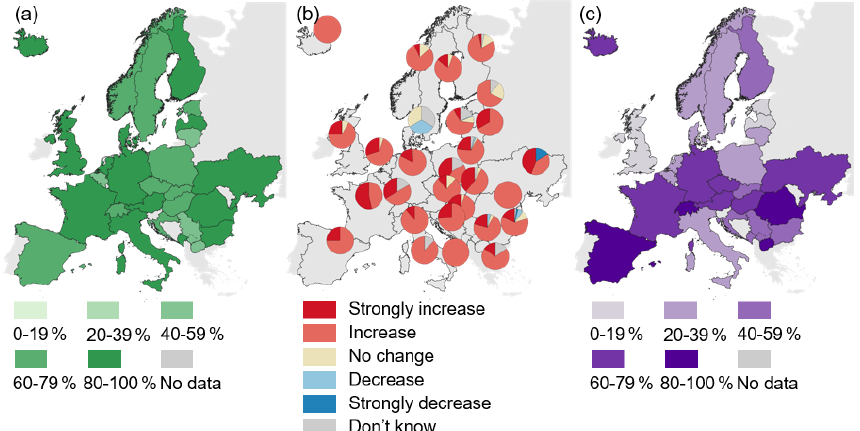
Figure 4. Perception of climate change effect on drought management in Europe shown as percentage of participants responding to questions about (a) whether future climate change will may affect water resources, (b) how droughts may change in future, and (c) whether drinking water providers in the future would have to distribute water to fewer consumers due to shortages, e.g. “rota cuts”. Results are based on a pan-European survey designed by the IAHS – Panta Rhei “Drought in the Anthropocene” working group and conducted in 28 countries.